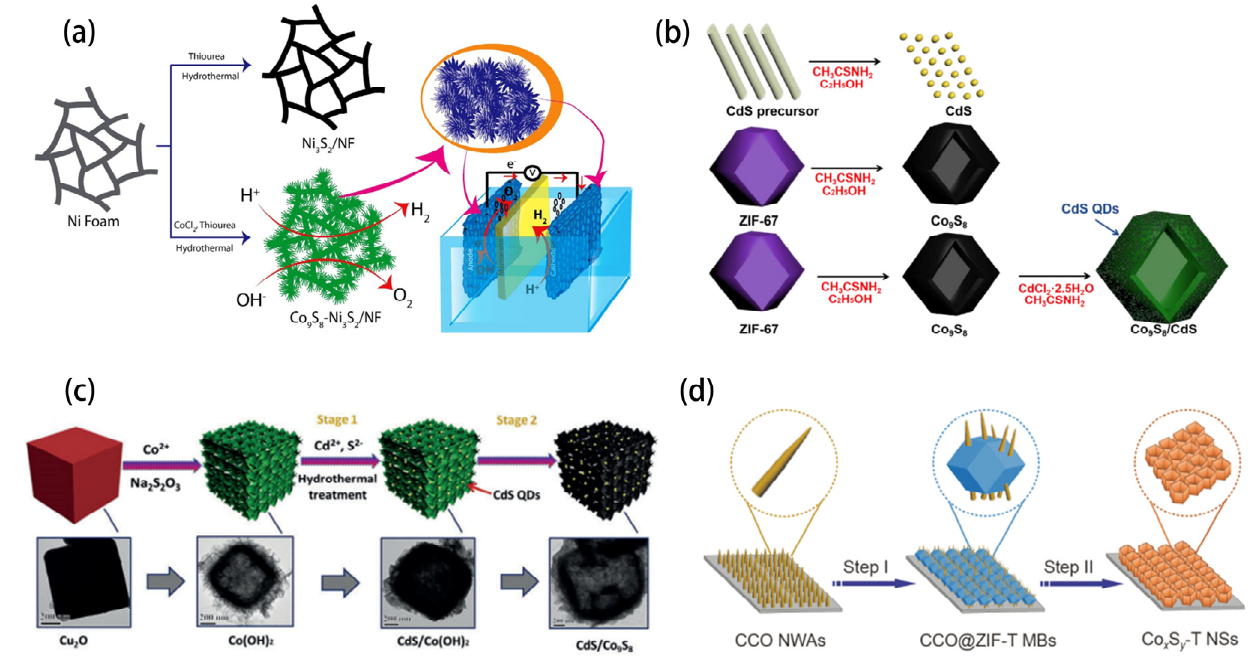
Figure 5. ( a ) Schematic illustration of the synthesis of Co 9 S 8 -Ni 3 S 2 /NF through the hydrothermal route and the use of this system as the bi-functional electrode in water electrolysis. Reprinted